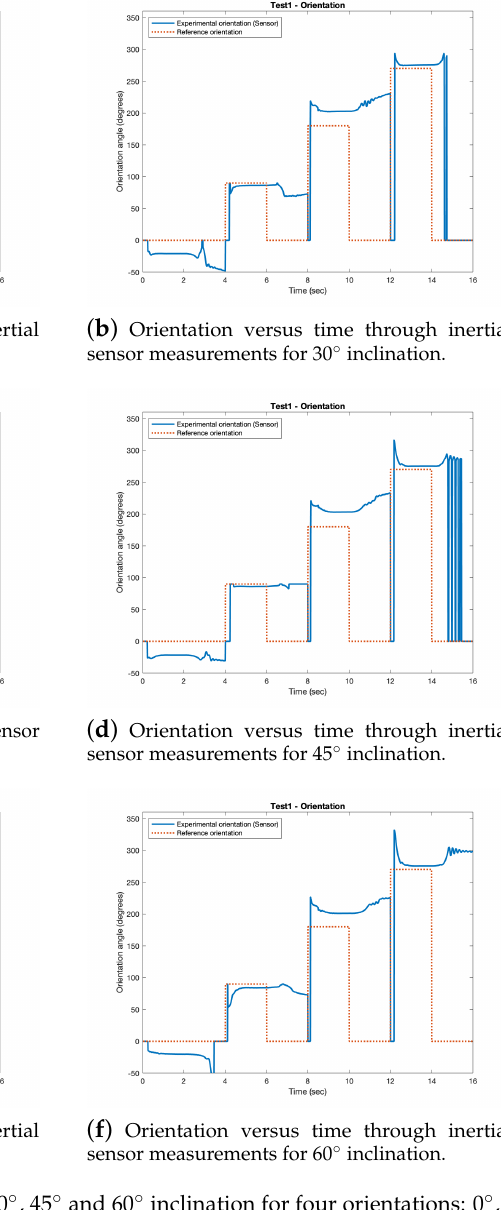
Figure 19. Test 1—Sensor data. Fixed 30 ◦ , 45 ◦ and 60 ◦ inclination for four orientations: 0 ◦ , 90 ◦ , 180 ◦ and 270 ◦ . The blue line is the experimental data obtained from the encoder and the orange dotted line is the